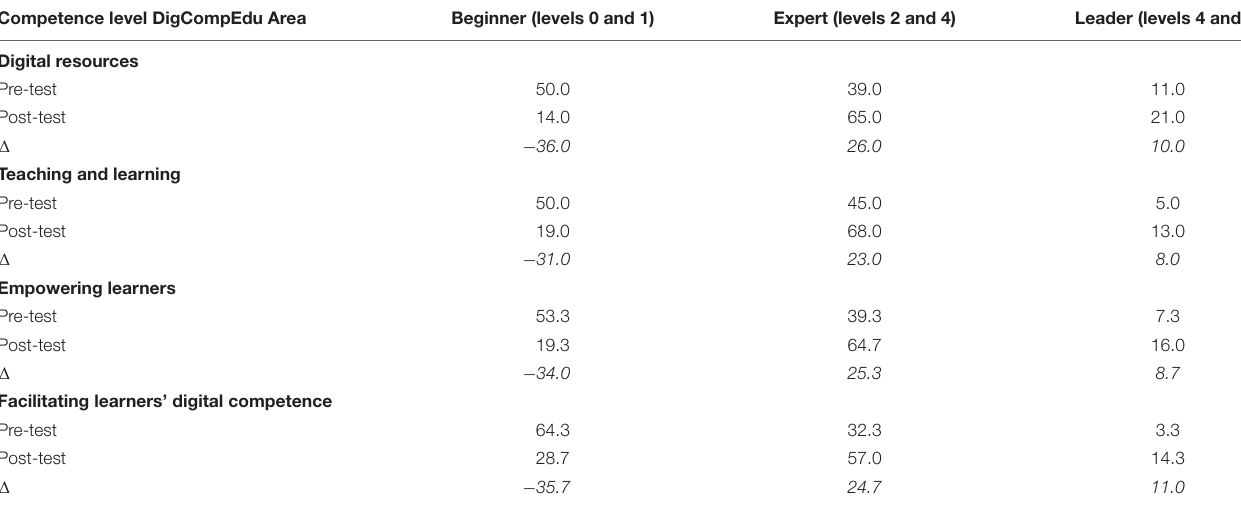
TABLE 2 | The level of Case 2 participants’ digital competences, by